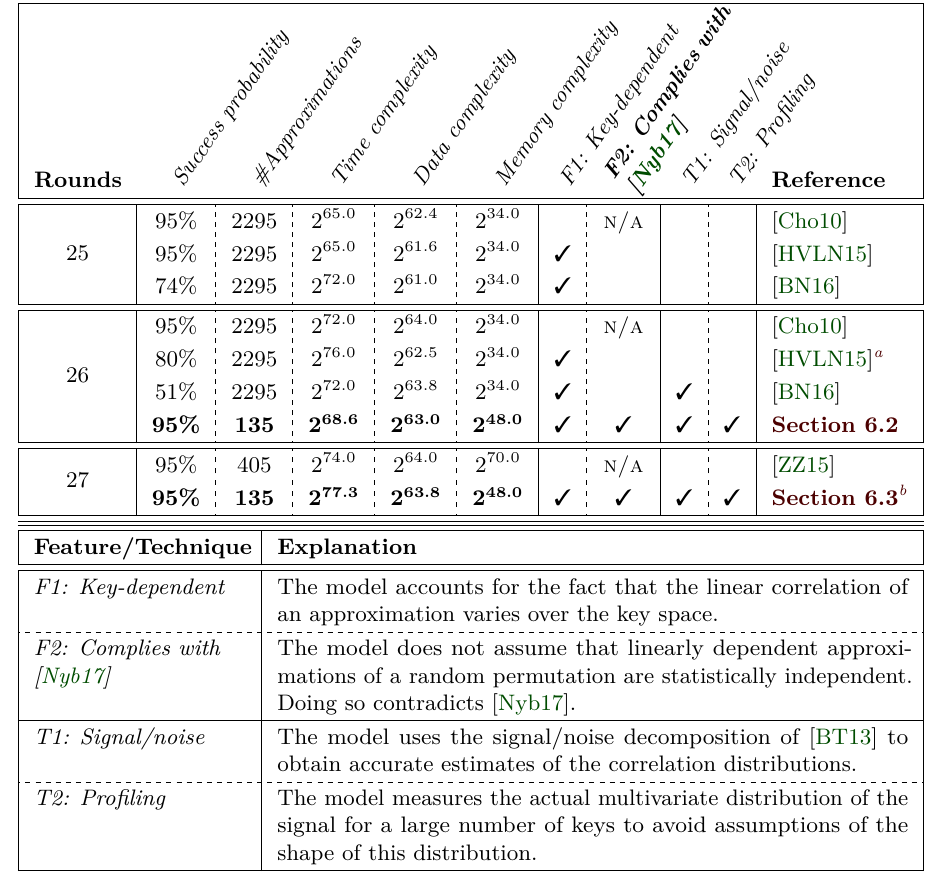
Table 1: Comparison of attacks on present . The attacks of [Cho10] and [ZZ15] do not take the key-dependence into account. All models, except the one presented in this work, use assumptions that contradict the equivalence of linear independence and statistical independence of linear correlations shown in